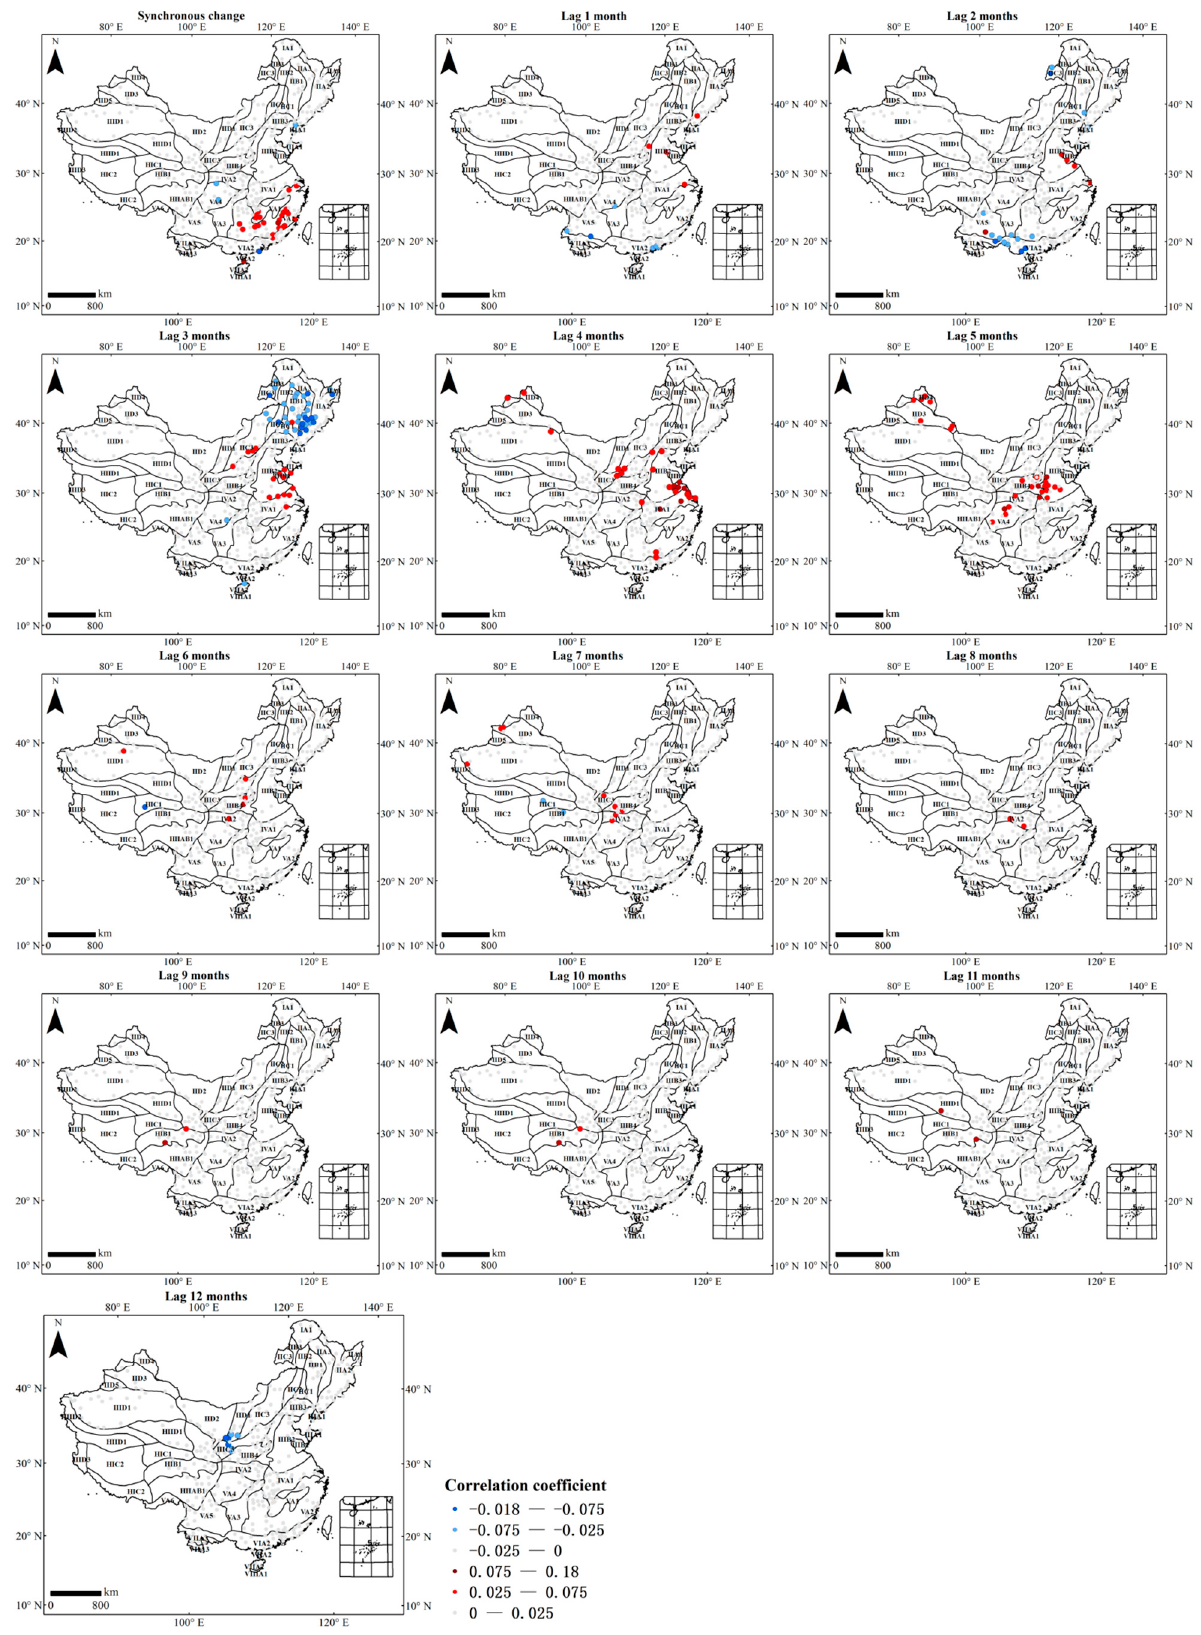
Figure 2. Extent and time lag of drought due to the strongest El Niño event (identified by Niño3.4 index).